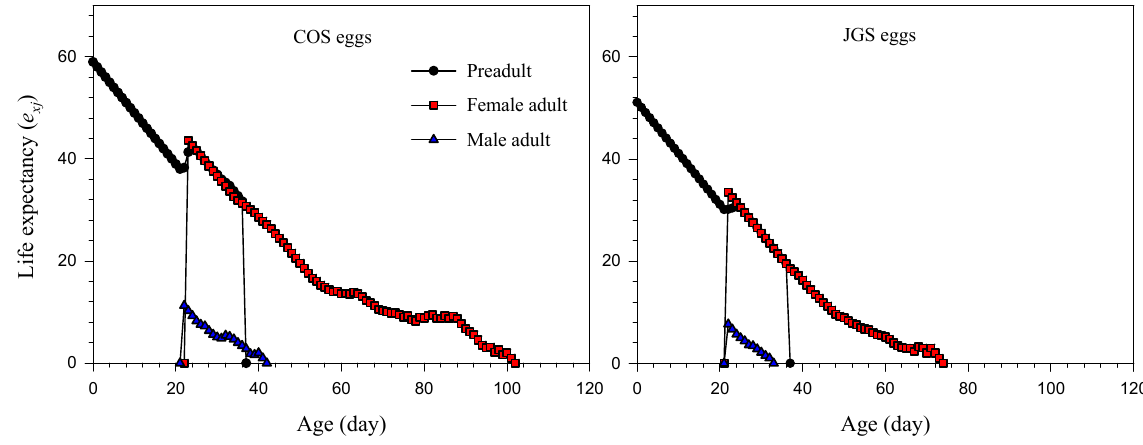
Figure 3. Life expectancy ( e xj ) of Anastatus japonicus parasitizing COS and JGS eggs. The reproductive value of A. japonicus ( v xj ) first gradually increased with age; reaching the peak at the ages of 32 days (86.69 d − 1 ) and 30 days (65.39 d − 1 ) when parasitizing COS eggs and JGS eggs, respectively, and then gradually decreased with age (Figure 4). The v xj of adult females dramatically increased when they started oviposition (Figure 4). The reproductive value at the age of zero ( v 01 ) was equal to the finite rate of increase ( λ ). The reproductive values of newly laid eggs of A. japonicus parasitizing COS eggs and JGS eggs were 1.16 and 1.15, respectively.